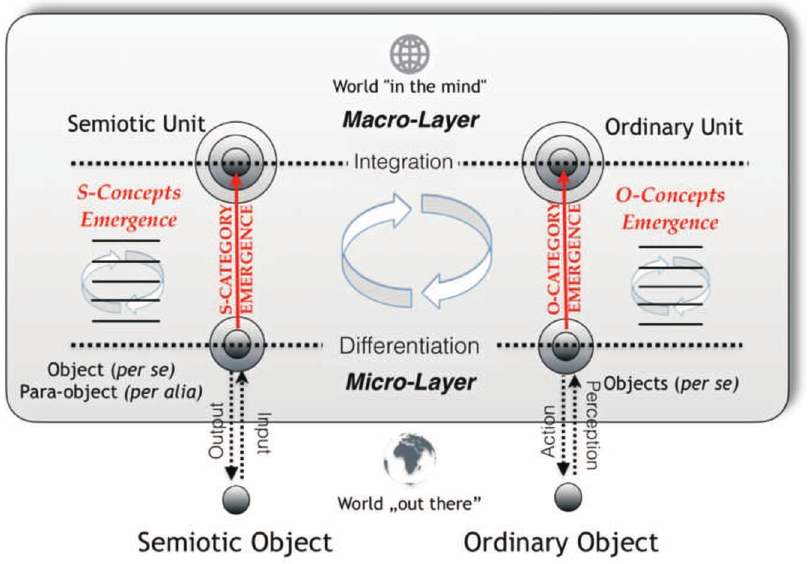
Figure 1. The Tetradic view of Emergence within Semiosis and Noesis and between